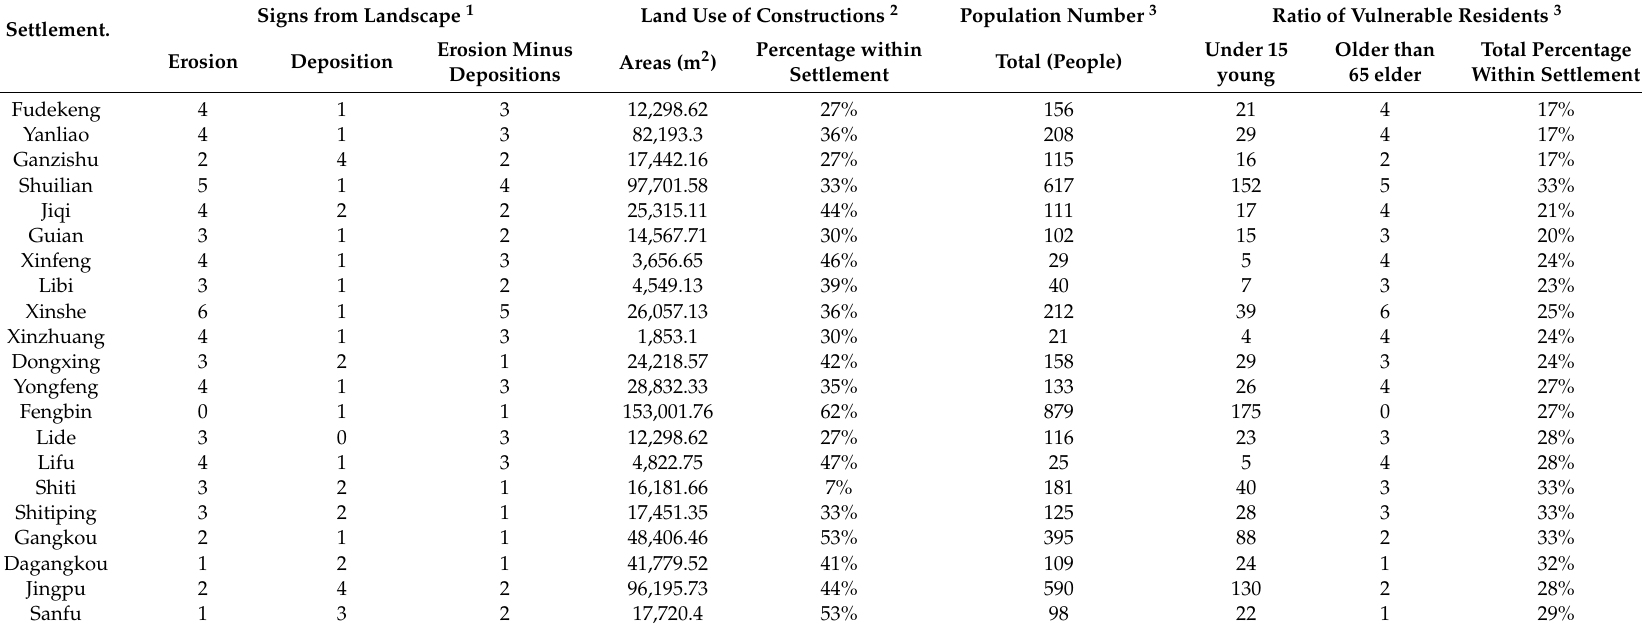
Table 3. Assessment of the di ff erent settlements in the study